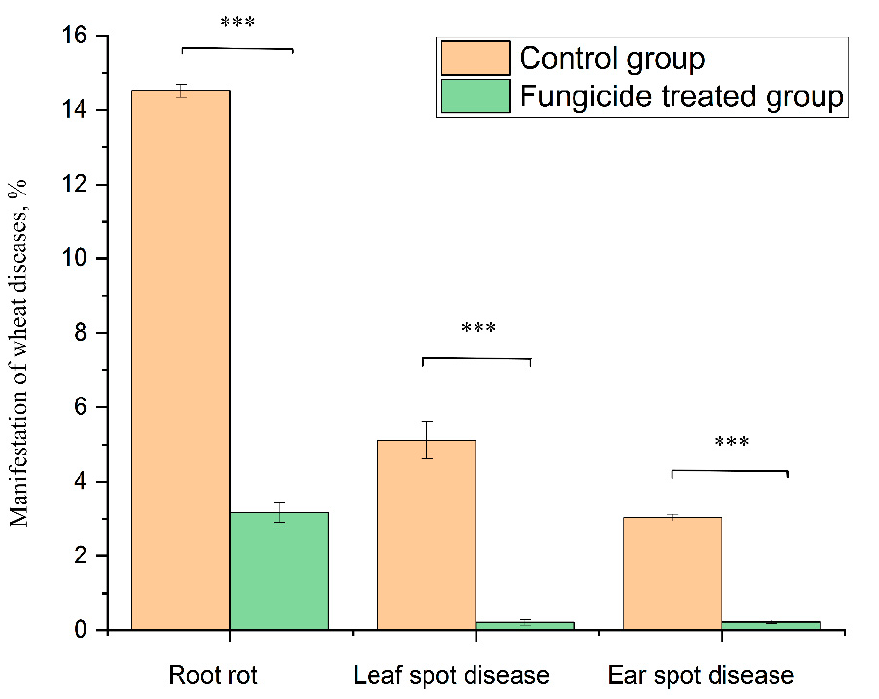
Figure 9. Wheat disease severity and incidence in the control and fungicide-treated plants. Data present mean ± standard deviation (n = 50). *** p < 0.001.